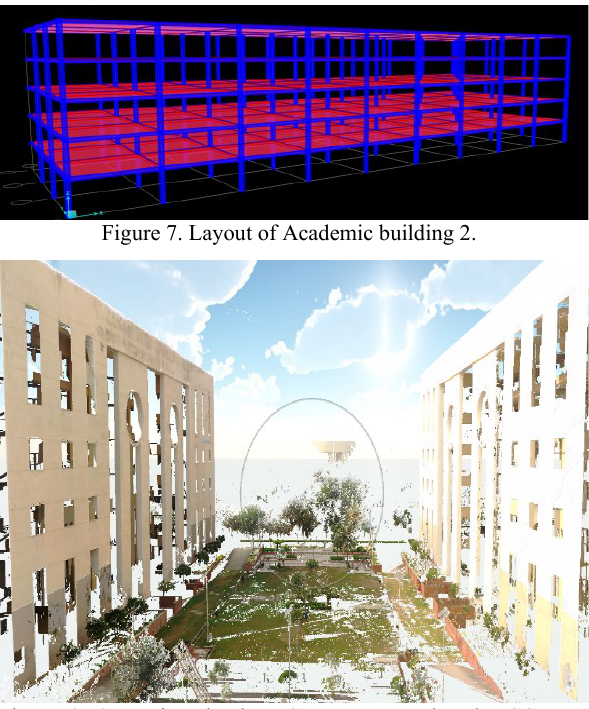
Figure 8. 3D point cloud RGIPT process data by SCENE softwere.